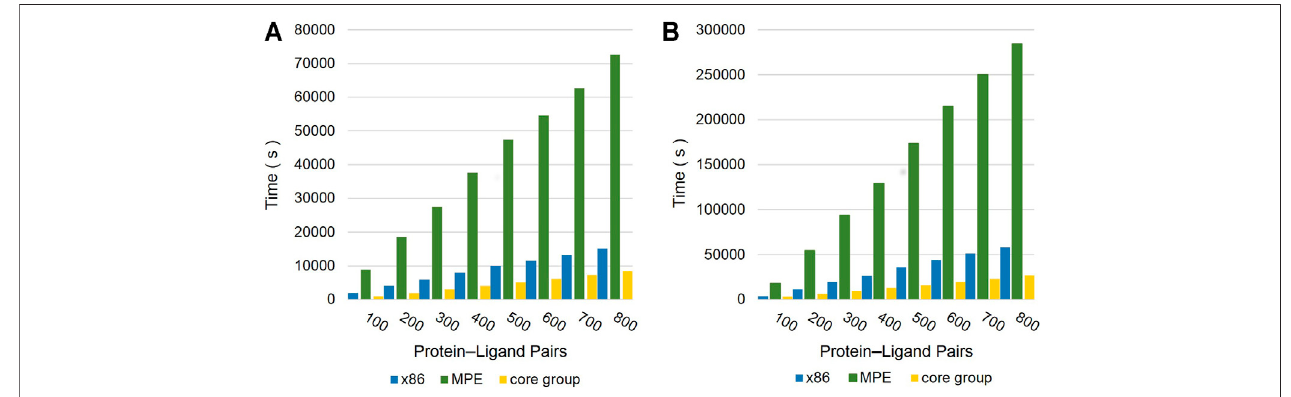
FIGURE 13 | Comparison of the calculation speed in three ways: X86, MPE, and the core group. (A) The torsion of the docking molecule is 0 – 6. (B) The torsion of the docking molecule is 7 – 12.